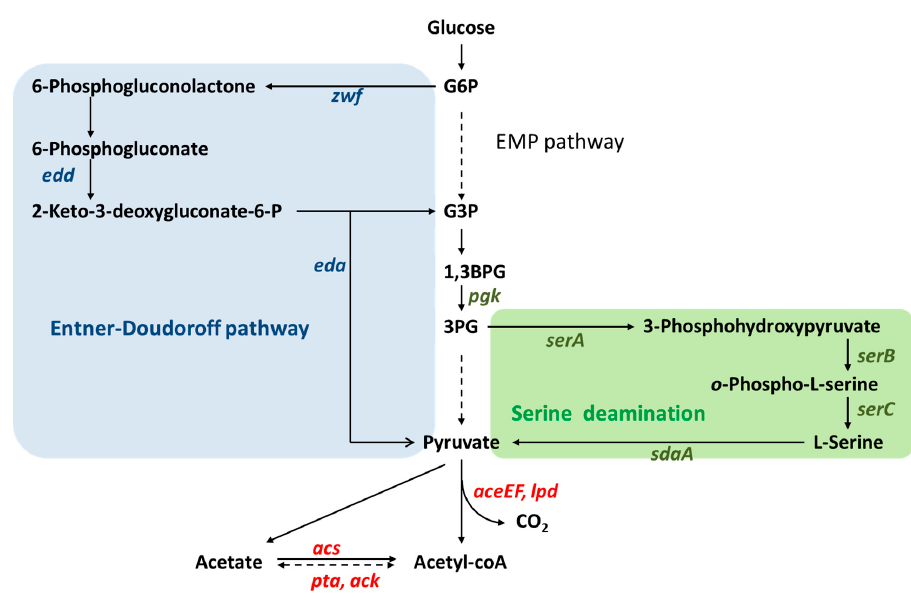
Figure 2. Pathways used to channel more carbon flux toward acetyl-CoA. Entner–Doudoroff pathway (ED pathway; blue shadowed area) is able to convert G6P into G3P and pyruvate independent from the conventional EMP pathway. Serine deamination (SD pathway; green shadowed area) on the other hand channeling pyruvate synthesis from the deamination of serine, which comes from the EMP pathway intermediate, 3PG. Overexpression of glycolysis, ED pathway, and